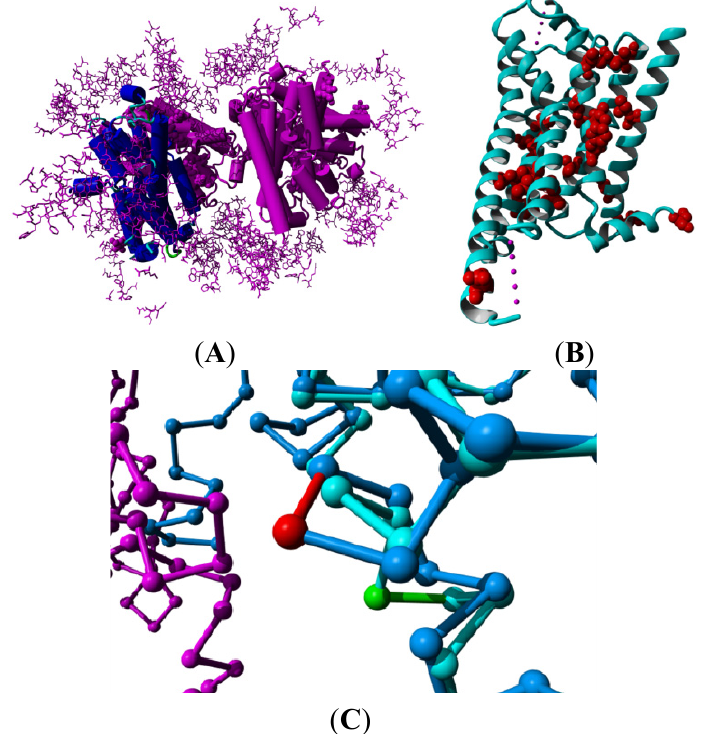
Figure 2. Examples of crystallization artifacts. ( A ) The turkey β 1-adrenoceptor, PDBid = 2vt4 [16]. The asymmetric unit contains a dimer of non-natural up-side-down dimers. The A subunit in the first dimer is shown in blue while the other three monomers are shown in purple. Crystallization additives are shown in a ball representation. Residues in other molecules in the crystal that have at least one atom within 10 Å from any of the four subunits in the asymmetric unit are shown as a purple stick model; ( B ) Ribbon representation of bovine rhodopsin, PDBid = 1f88 [2]. All residue positions mutated for thermostabilization in any of the structures mentioned in this article are shown in a red ball-representation; and ( C ) Trace representation of the β 2 adrenoceptor, PDBid = 2r4s [23] shown in dark blue bound to an antibody shown in magenta. The β 2 adrenoceptor with PDBid = 3ny9 [12] that does not bind anything in this region is superposed and shown in light blue. Both are bound to inverse agonists. The antibody distorts helix VIII resulting in a bulge in 2r4s (shown in red) followed by an anti-bulge (3 helix) at the location where 10 3ny9 has a normal helix (shown in